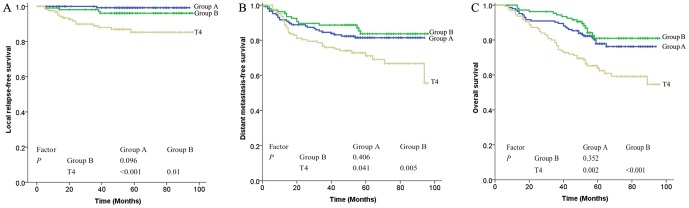
Survival rate by T-category in 375 patients: (A) local relapse-free survival, (B) distant metastasis-free survival, and (C) overall survival.Group A: T3 without MRI-detected cranial nerve involvement; Group B: T3 with MRI-detected cranial nerve involvement.